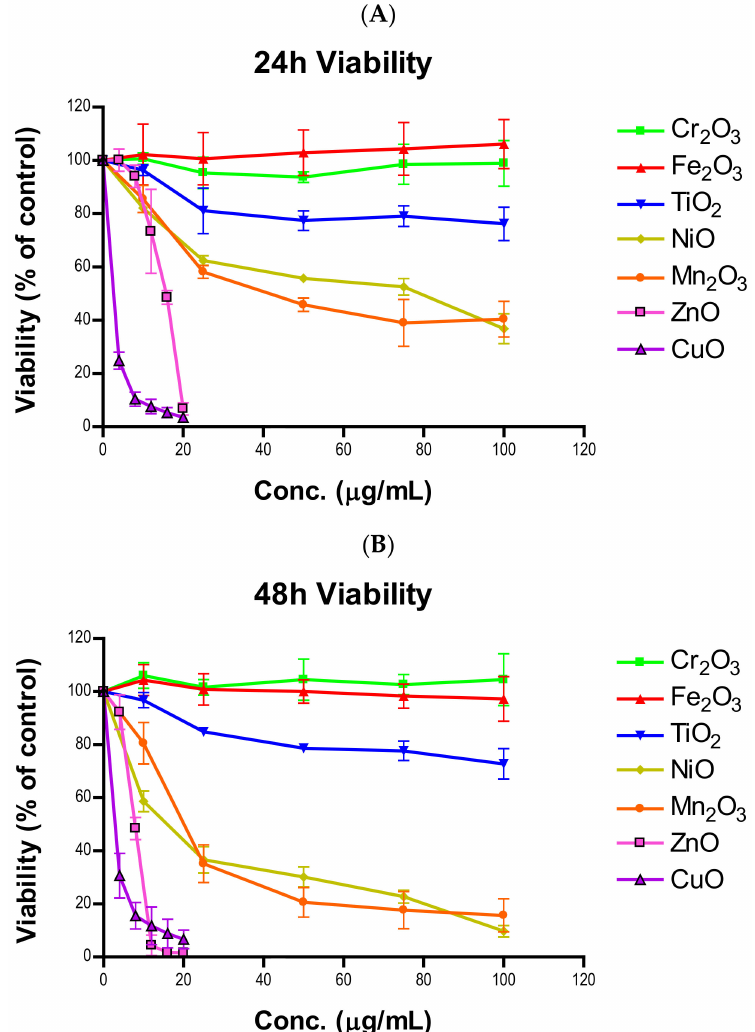
Figure 1. Viability of A549 cells after ( A ) 24- or ( B ) 48-h exposure to various concentrations of one of seven